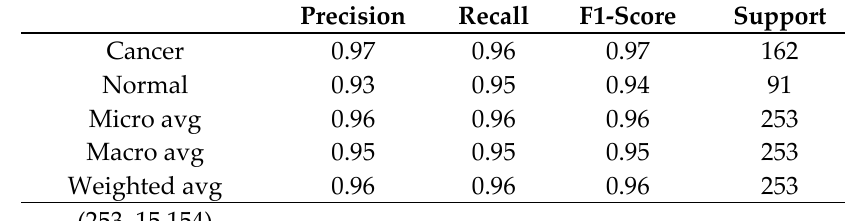
Table 5. Classification Results for Decision Tree (DT).